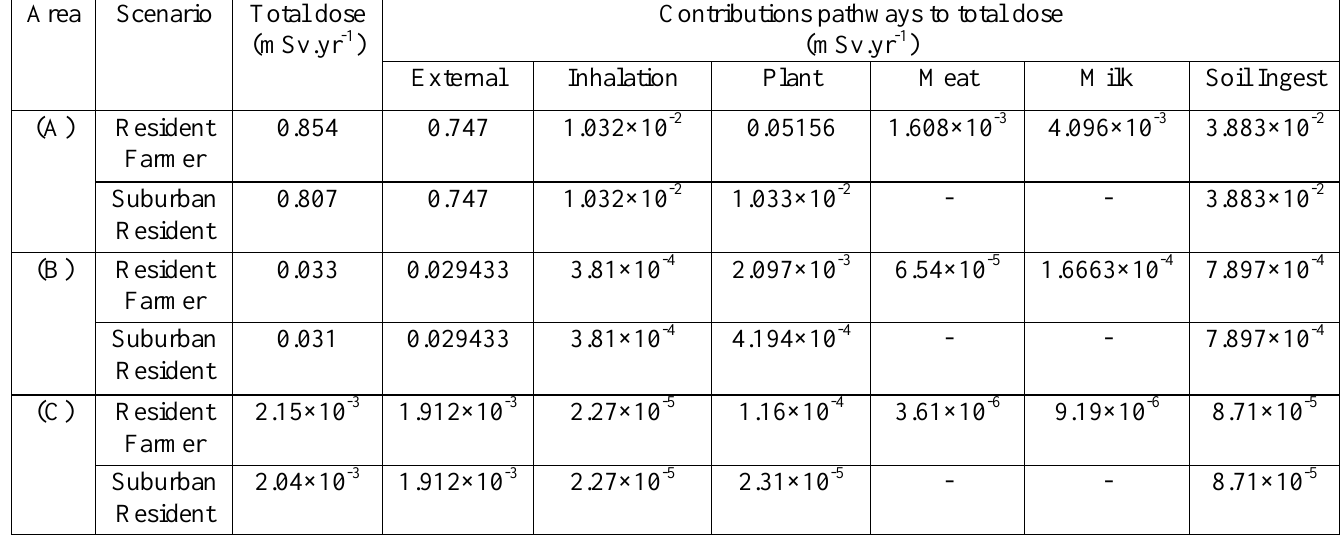
Table 3: The results of RESRAD for calculations the dose of area A, B and C for both scenarios. Area